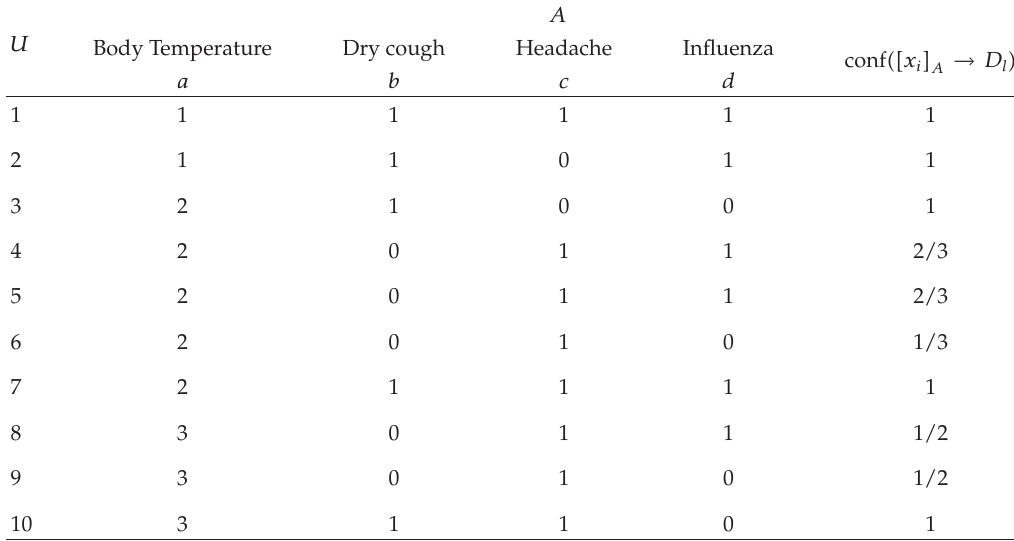
Table 2: The original decision table of patients’